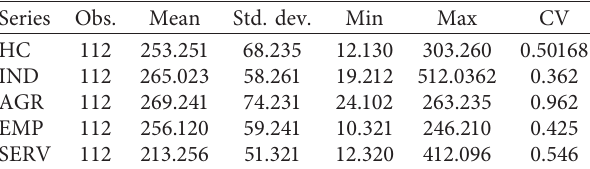
Table 4: Descriptive statistics for quarterly data. Table 2: Dynamic equation (dependent variable � lowest 20%